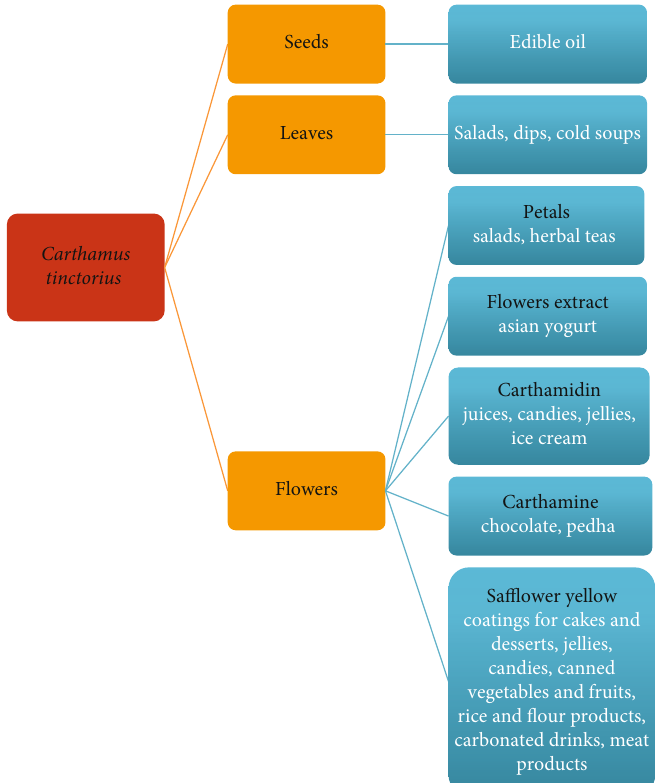
Figure 2: The use of sa ffl ower fl owers and its components in food